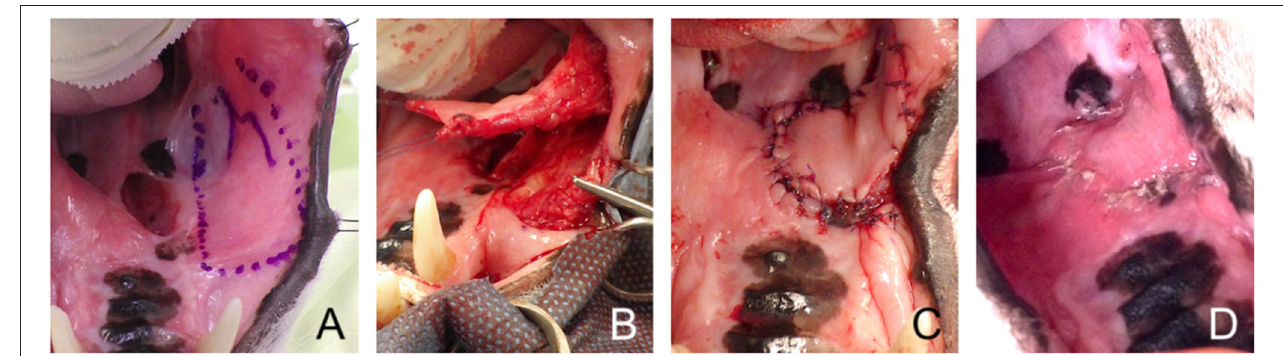
FIGURE 6 | Drawing depicting full-thickness labial/buccal advancement flaps for upper or lower lip defects.